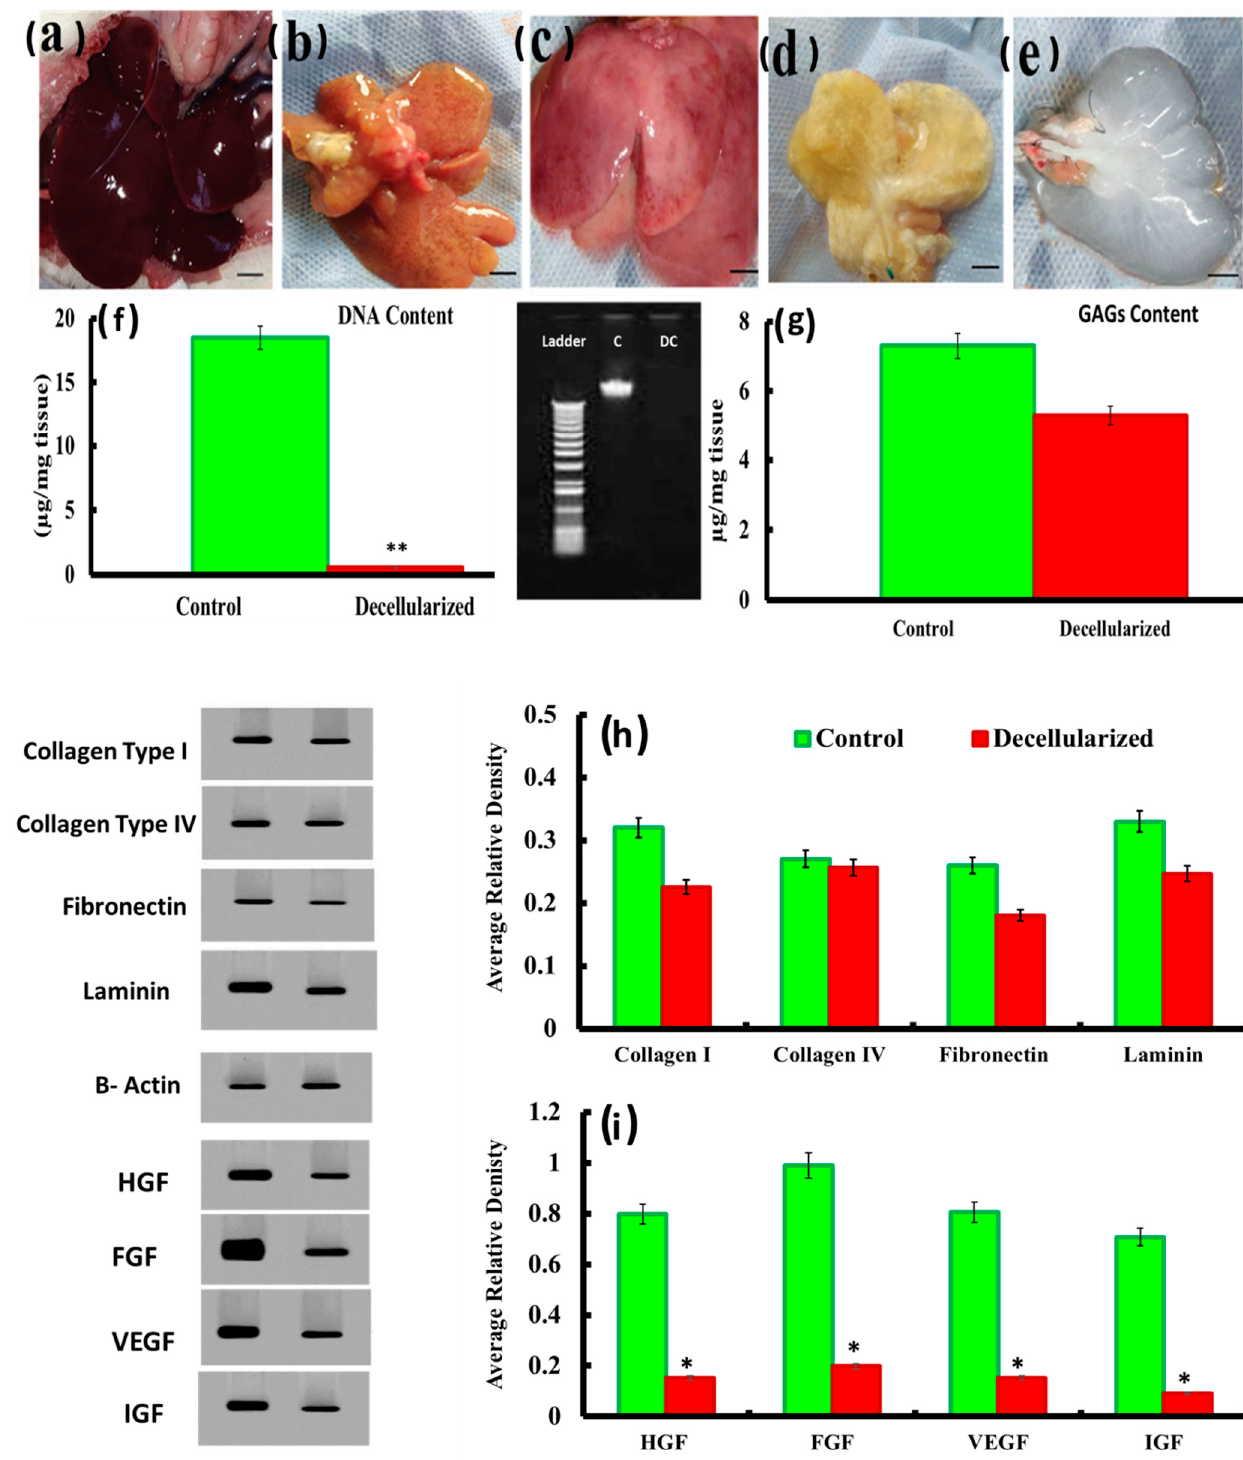
Figure 1. Representative images of livers during decellularization process at ( a ): 0 h; ( b ): 18 h;( c ): 48 h; ( d ) 72 h, and ( e ): 96 h. ( f ): DNA content analysis; ( g ): glycosaminoglycans (GAGs) analysis of normal liver compared to decellularized (DC) rat liver scaffold; ( h , i ): Western blot assay for ECM components & growth factors of normal liver and after decellularization process. β -actin was used as housekeeping protein and quantification was performed using Image analysis software on the Chemi Doc MP imaging system. Superscripts (*) indicate significant differences at p < 0.05. Superscript (**) indicates significant differences at p < 0.01. Data are shown as mean ± S.E.M, n =